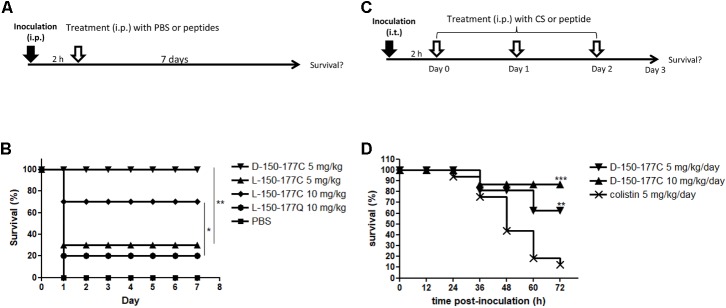
Comparisons of in vivo protection efficacy of HBcARD derivatives in two animal models. (A) In a mouse sepsis model, ICR mice (n = 10/group) were i.p. inoculated with S. aureus ATCC19636 (4∗106/mouse) before treatments at 2 h post-inoculation. The survival rates were monitored for 7 days after injection. (B) All PBS control mice died at day 1, and only 20% of mice treated with a peptide L-150-177Q survived. Administration of L-150-177C peptide at the dose of 5 and 10 mg/kg can rescue 30 and 70% of mice from death, respectively. When treated with 5 mg/kg of D-150-177C, all mice survived. (C) In a lung infection mouse model, 6–8-week-old male C57BL/6JNarl mice were anesthetized by Isoflurane via inhalation, before intra-tracheal (i.t.) inoculation with A. baumannii (3.5 × 108 CFU/mouse). Two hours after inoculation, mice were intraperitoneally (i.p.) injected daily with either colistin (CS) or HBcARD peptides for three consecutive days. The survival rates were monitored for 3 days after infection. (D) C57BL/6JNarl mice (16 mice/group) were i.t. inoculated with A. baumannii TCGH46709 (colistin-resistant strain) before treatment with either colistin (5 mg/kg) or D-150-177C peptide (5 and 10 mg/kg). There was a dose-dependent effect on the survival rate of mice receiving D-150-177C. The survival rates of mice treated with D-150-177C were significantly higher than that with colistin treatment. This result indicated that D-150-177C was more potent than colistin for killing colistin-resistant A. baumannii. ∗P < 0.05; ∗∗P < 0.01; ∗∗∗P < 0.001.